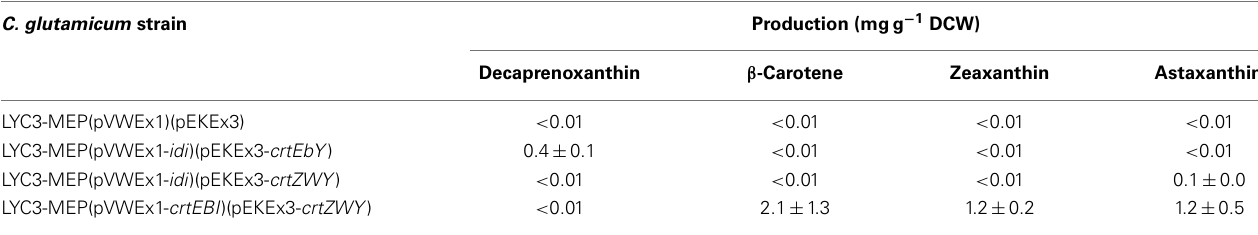
Table 5 |Astaxanthin and decaprenoxanthin production by recombinant C. glutamicum strains with improved IPP supply